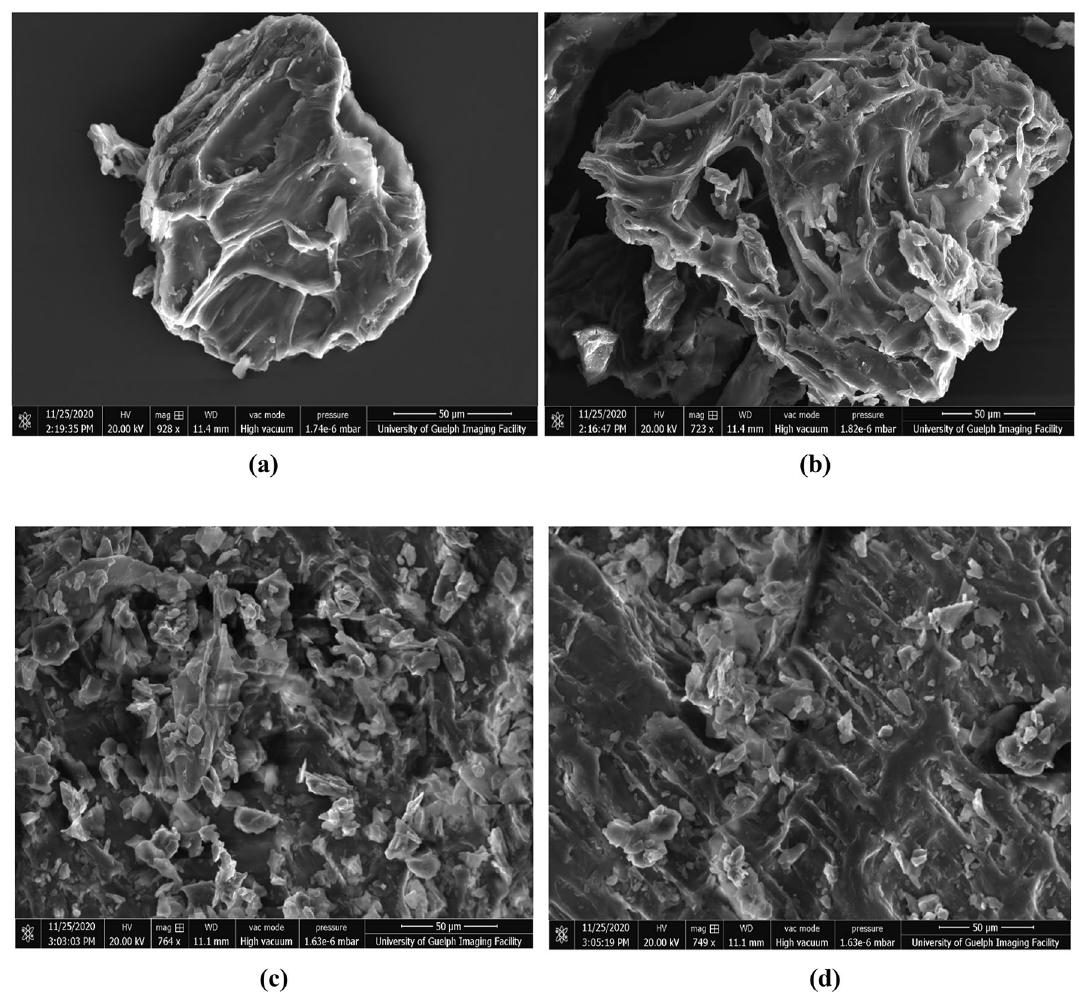
Figure 6. SEM micrographs of ( a ) Carrot powder untreated, ( b ) Maceration, ( c ) MAE, ( d )